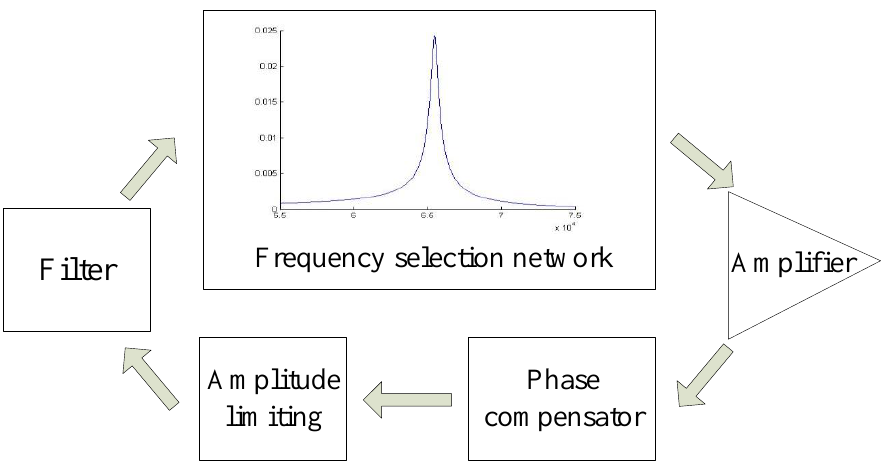
Figure 4. Schematic illustration of a SAD